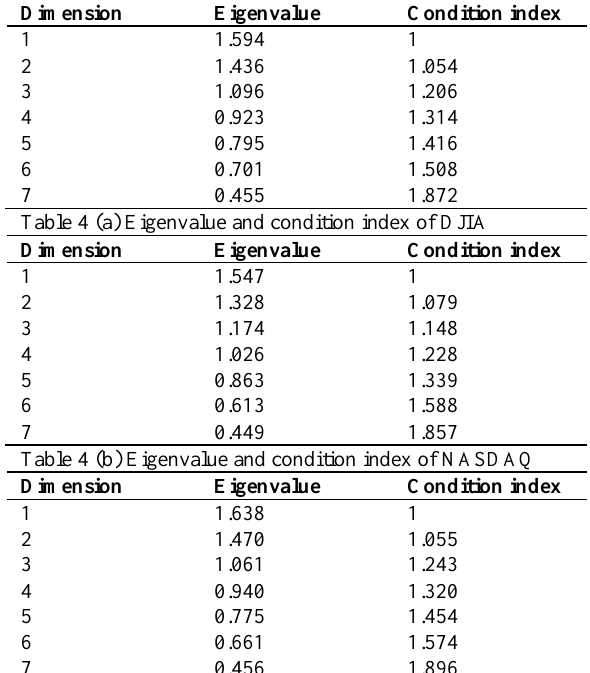
Table 4 (b) Eigenvalue and condition index of NASDAQ